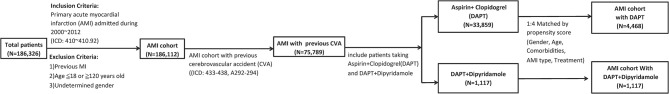
Flow-chart of the study cohort. There were 186,326 patients in Taiwan between January 2000 and December 2012 with a primary diagnosis of AMI (IC codes: 410–410.92). Patients were excluded who had a previous admission for AMI, were aged ≤ 18 or ≥120 years old, and whose sex was undetermined. Among the AMI cohort of 186,112 cases, 75,789 patients who were previously diagnosed with cerebrovascular accidents (CVA) (ICD: 433–438, A292–294) were analyzed. We included 1,117 patients taking aspirin and clopidogrel in DAPT group, and 33,859 patient taking DAPT plus dipyridamole in DAPT-dipyridamole group. Propensity score matching in a ratio of 1:4 based on variables of gender, age, hypertension, dyslipidemia, DM, PVD, ESRD, COPD, and PCI was adopted. Finally, we enrolled 4,468 patients in the DAPT group with aspirin and clopidogrel and 1,117 patients in the DAPT-dipyridamole group in our final analysis. AMI, acute myocardial infarction; CVA, cerebrovascular accident; DAPT, dual antiplatelet therapy; DM, diabetes mellitus; PVD, peripheral vascular disease; ESRD, end-stage renal disease; COPD, chronic obstructive pulmonary disease; PCI, percutaneous coronary intervention.